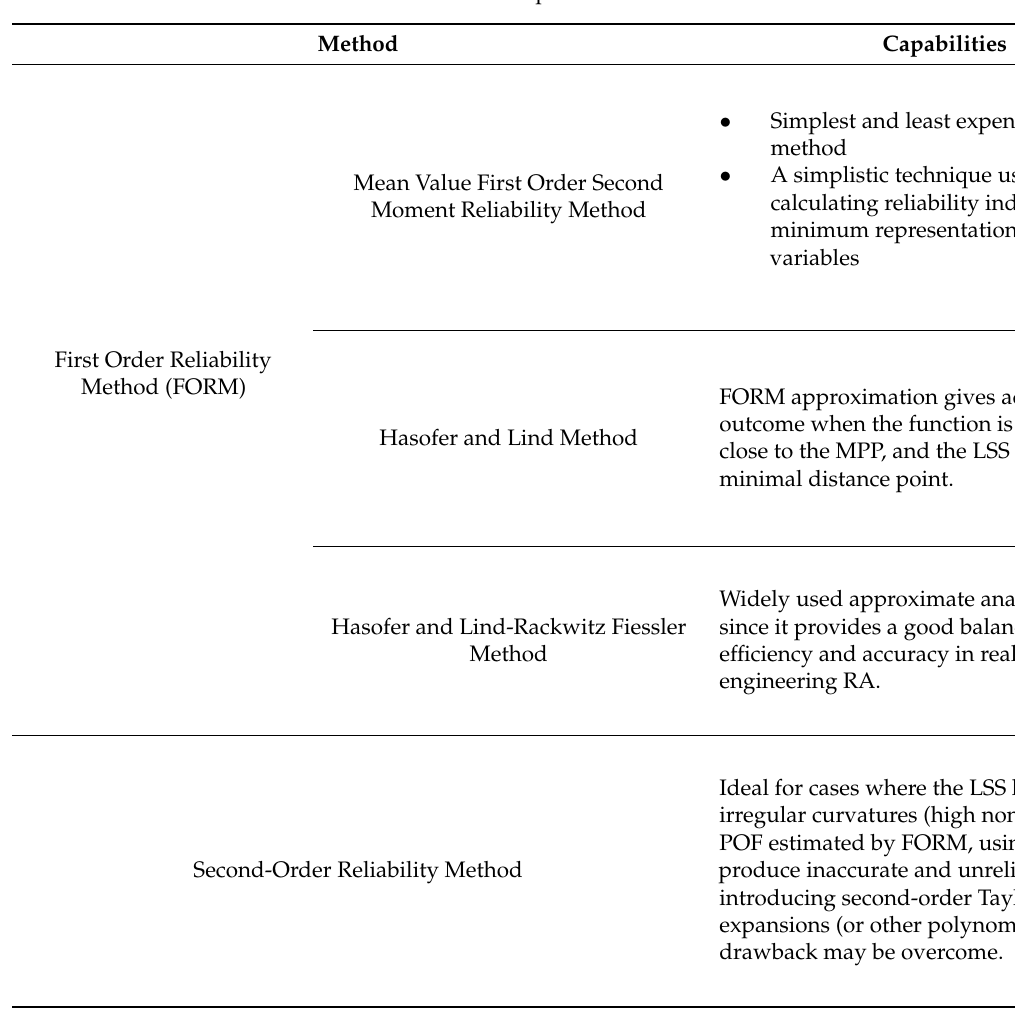
Table 1. Capabilities and limitations of the most common level III approximation structural reliability